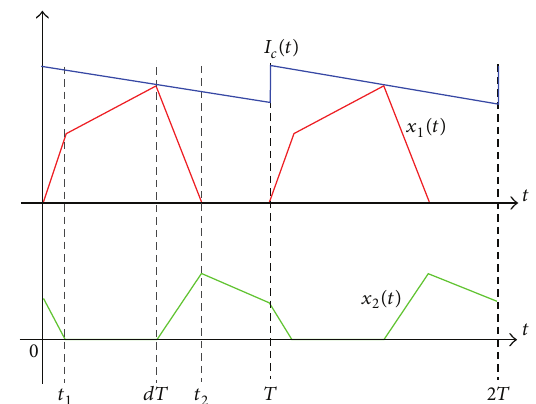
Figure 3: Behavior of primary (top) and secondary inductor (bottom) currents in steady